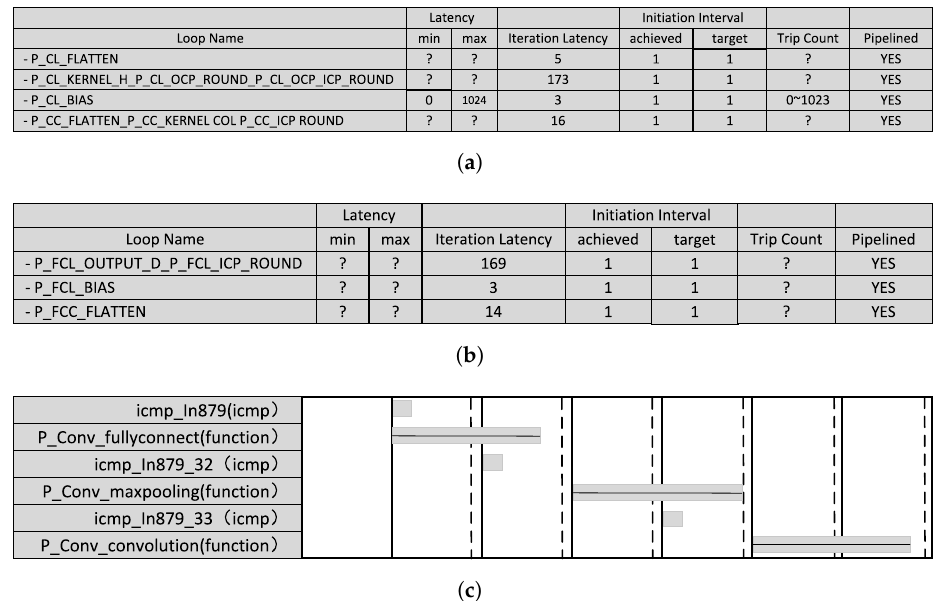
Figure 16. Pipeline experiment results: ( a ) Convolutional layer pipeline synthesis result. ( b ) Fully connected layer pipeline synthesis results. ( c ) Computational scheduling kernel pipeline diagram.